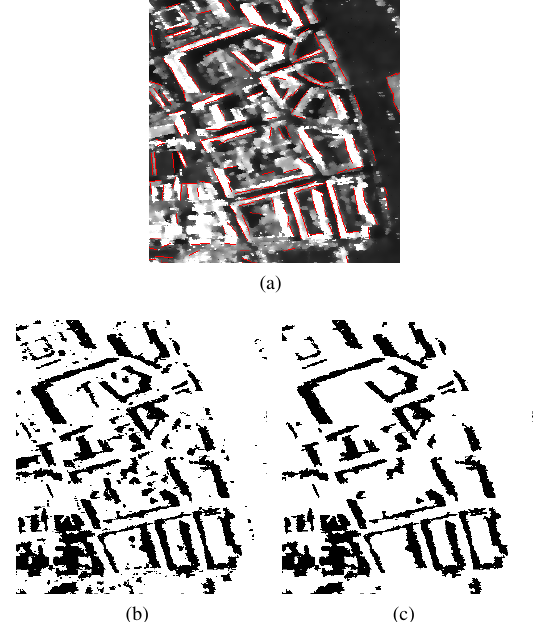
Figure 9: Illustration of image pre-segmentation: (a) detected lines (in red) superimposed with the radiometric image, (b) seg- mentation by thresholding intensity, (c) segmentation with line segment